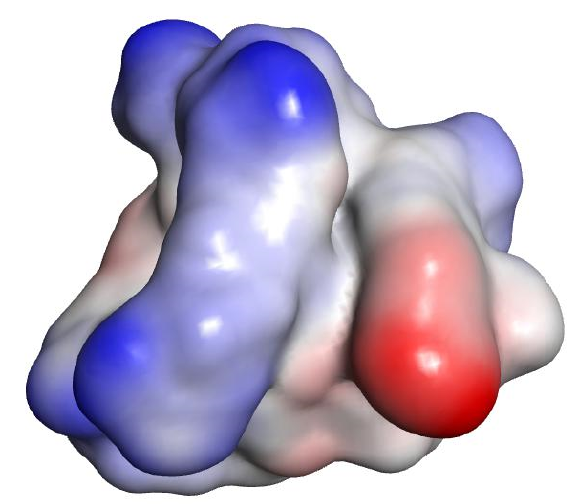
Figure 3. MEP of the representative complex formed by one compound 6 (WRWRW-NH 2 ) and three norfloxacin molecules. Negative values are shown in red, hydrophobic regions in grey and positive values in blue.